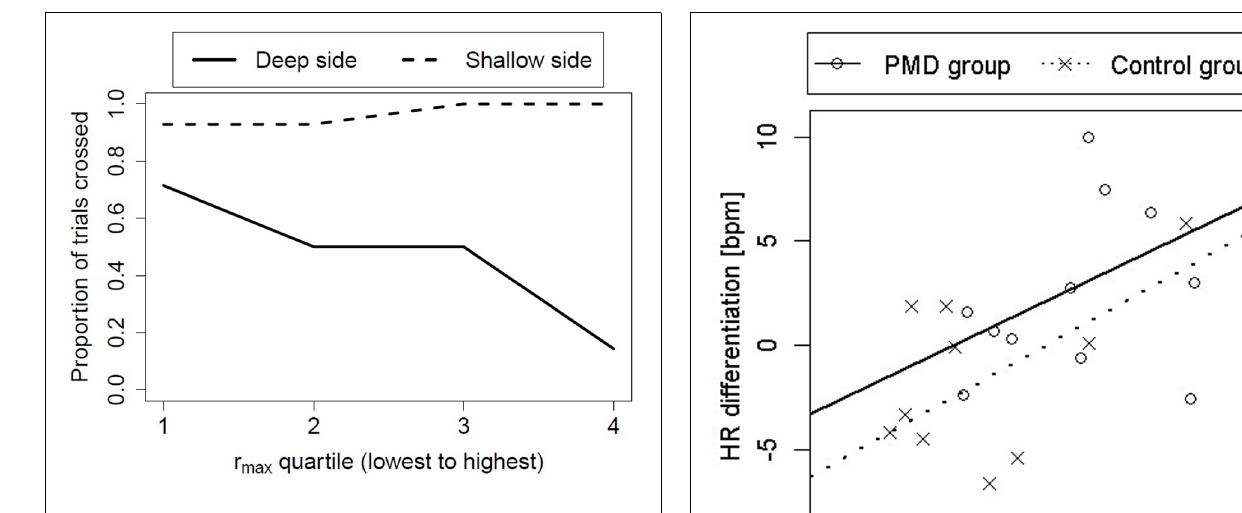
FIGURE 3 | The probability of crossing the deep or shallow sides of the visual cliff based on the infants’ responsiveness to peripheral optic flow in the moving room.